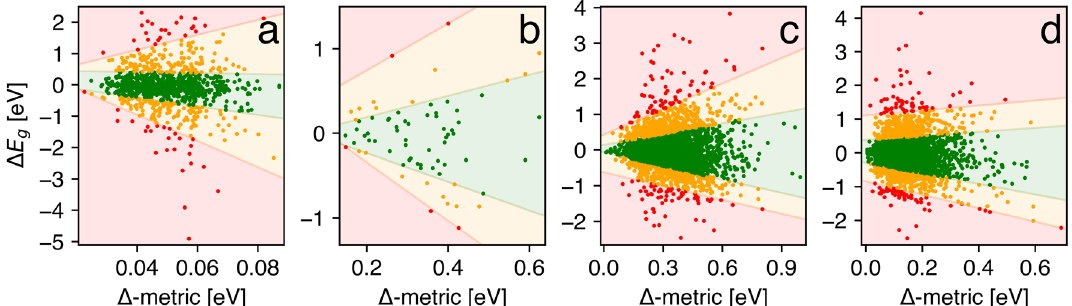
Figure 4. Predictive error as a function of the Δ-metric for the four considered use cases: ( a ) SNUMAT- MEGNet, ( b ) C2DB-GPR-CFID, ( c ) QMOF-KRR-ElemStat, and ( d ) OMDB-RF-PLMF. The colored areas correspond to the predictive intervals extracted by quantile regression: within one standard deviation (green), within two standard deviations (orange), and over two standard deviations (red).